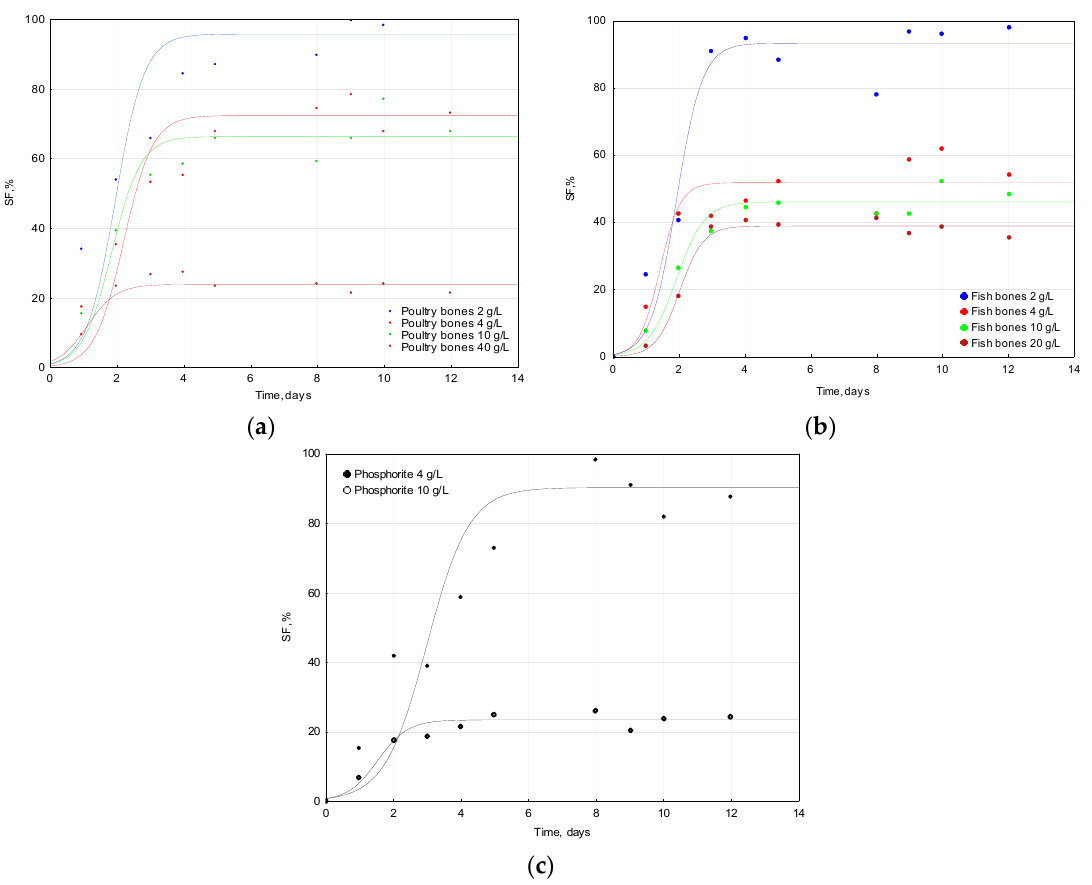
Figure 2. Solubilization Factor changes of phosphates in the process performed by A. ferrooxidans with the utilization of three different sources of phosphorus: ( a ) poultry bones; ( b ) fish bones; and ( c ) phosphorite.